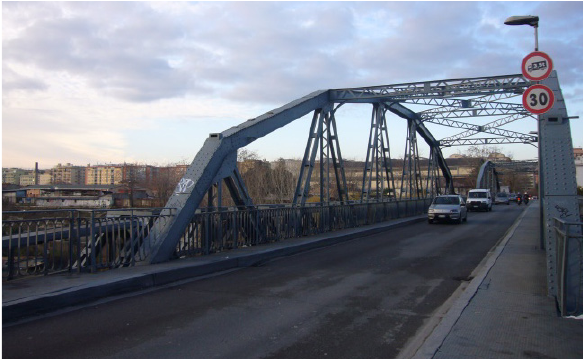
Figure 12. Industry Bridge transformed using iron elements of Alari Bridge